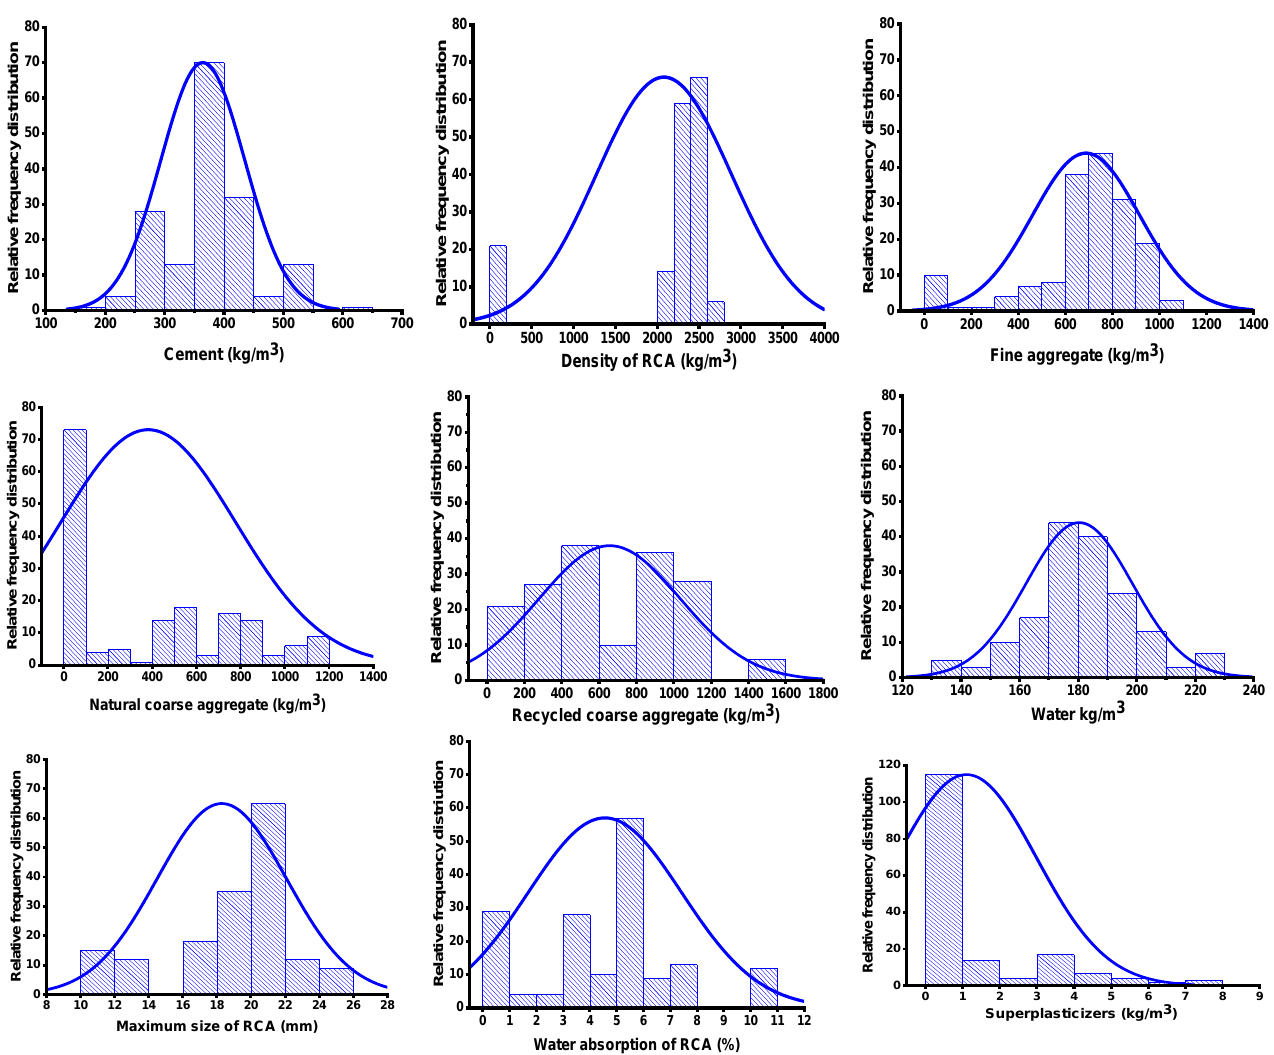
Figure 2. Reflection of the distribution for the input variable ’ s relative frequency. Table 1. Expressive inspection of the input variables.